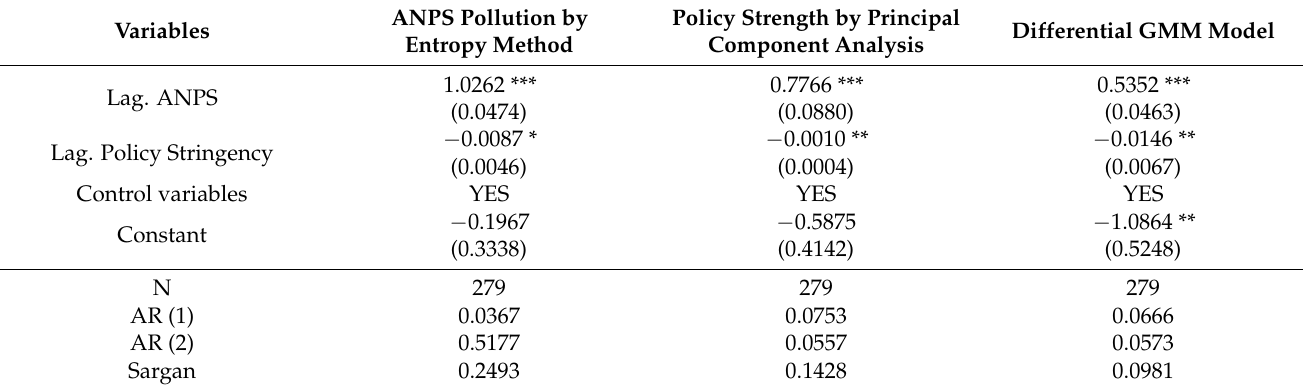
Table 8. Robustness test results of policy effects on ANPS